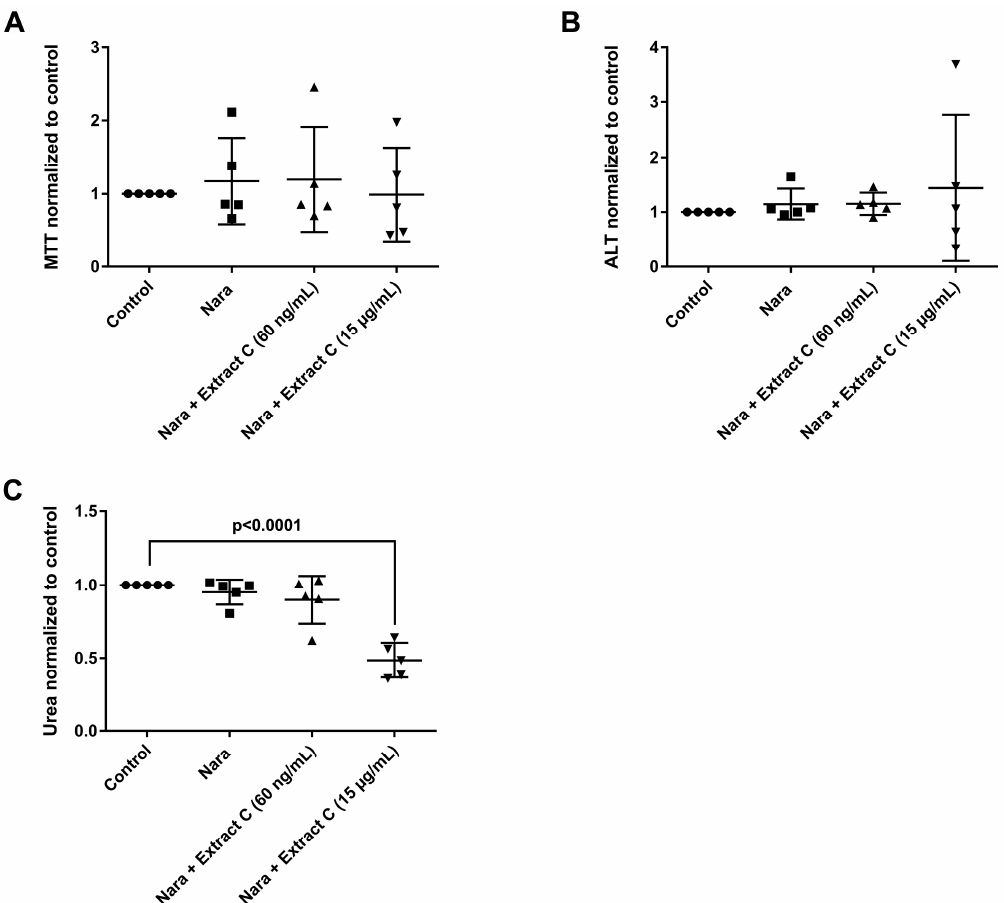
Figure 5. E ff ects of di ff erent Petasites hybridus extracts and Naratriptan on clinical liver function tests in cultures of human hepatocytes after daily treatment for 72 h. ( A ) MTT mitochondrial reductase activity. (B) Alanine aminotransferase activity. ( C ) Urea production. The data of individual donors are given normalised to the DMSO vehicle control. The Petasites hybridus extracts A, B and C are specified to 37%, < 1% and 19.1% petasin, respectively. Extract C is the marketed product Petadolex ® and human hepatocyte cultures were treated at therapeutic C max ( = 60 ng / mL) and > 49-fold therapeutic petasin C max ( = 15 µ g / mL) concentrations. Hepatocyte cultures were also treated with Paracetamol at therapeutic C max ( = Para; 20 µ g / mL) concentrations and in combinations with di ff erent Petasites hybridus extracts. The data were analysed with the GraphPad Prism software version 6.05.